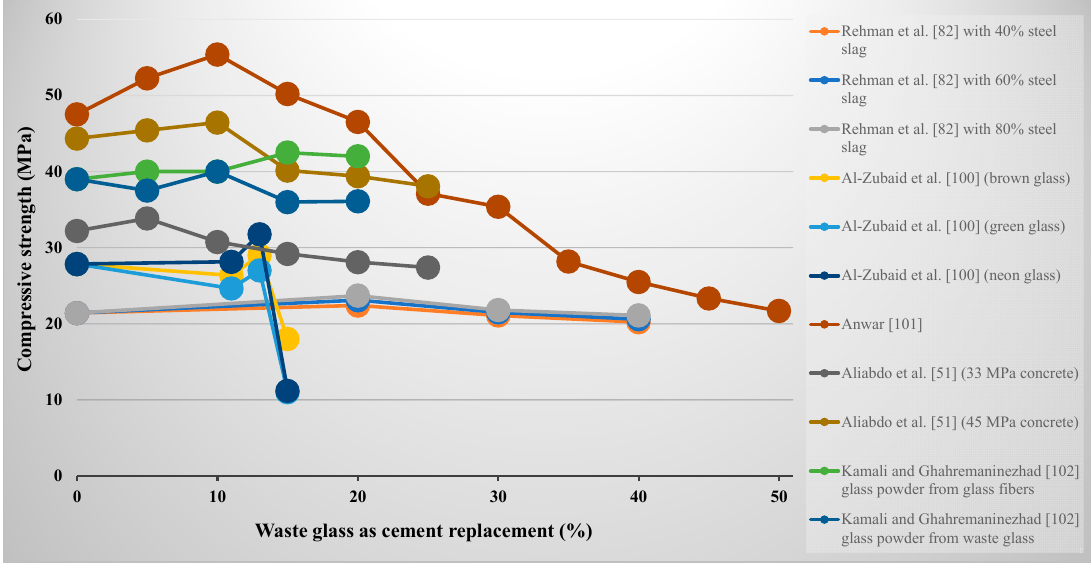
Figure 13. Effect of waste glass as cement replacement on 28-days compressive strength.